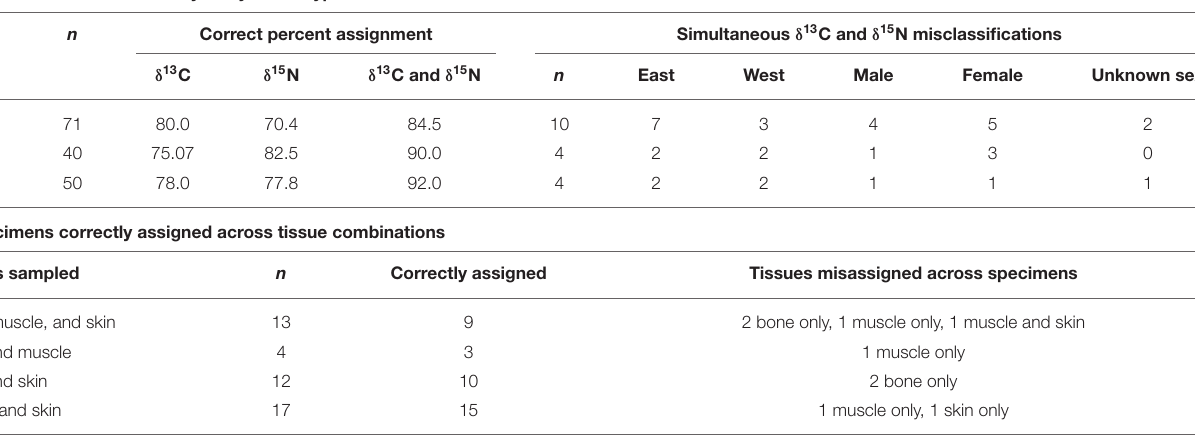
TABLE 2 | Quadratic discriminant analysis assignment percent probabilities for δ 13 C and δ 15 N values of Sowerby’s beaked whale specimens of opportunity collected in the east and west Atlantic Ocean basin, 1980–2019. A. Quadratic discriminant analysis by tissue type Tissue